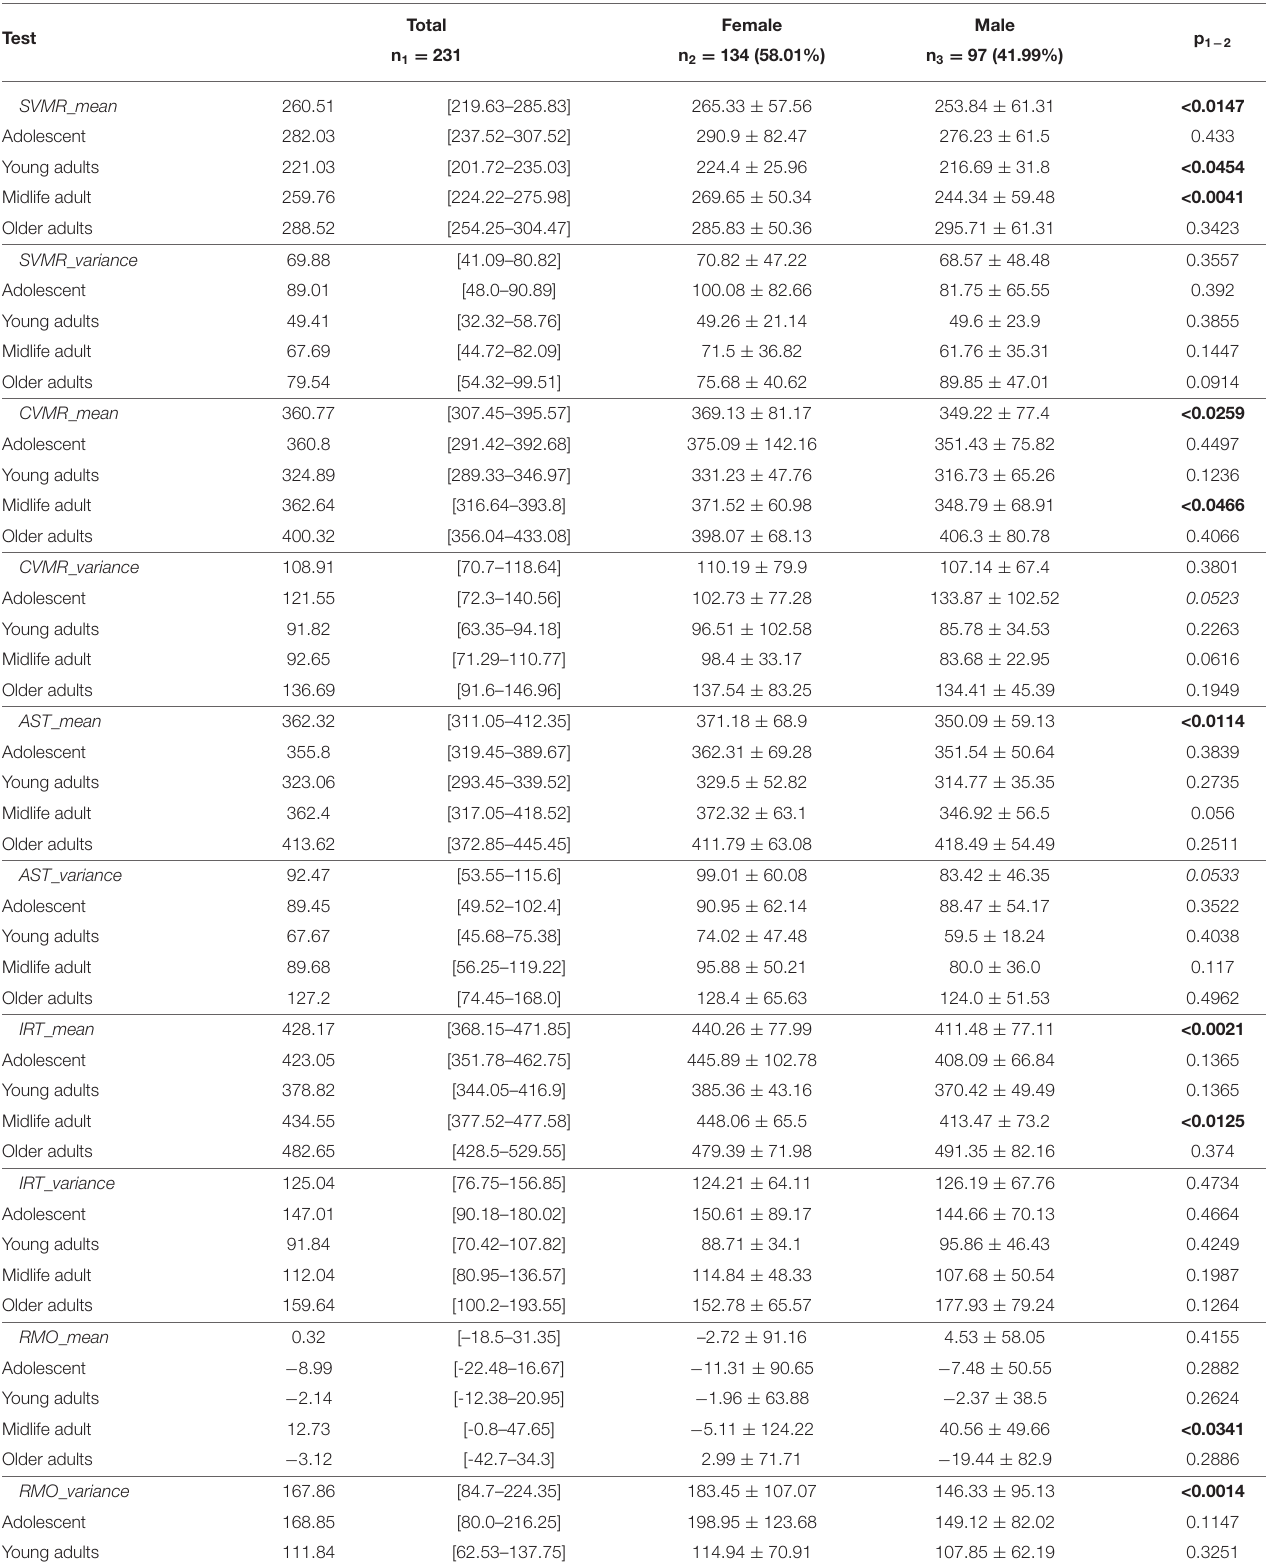
TABLE 3 | Comparison of test performance by age group and sex for the psychophysiological outcomes of brain atrophy